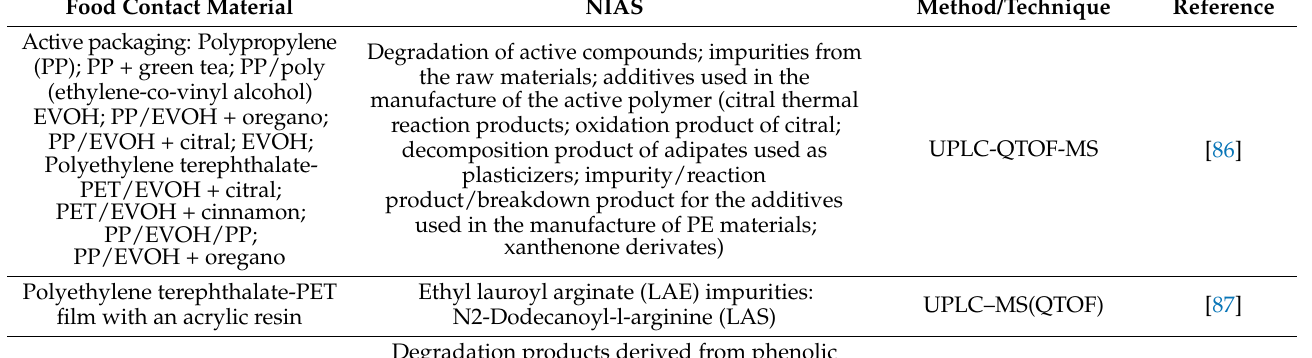
Table 5. Studies published in the literature on impurities (NIAS) Identification in different plastic food packaging. Food Contact Material NIAS Method/Technique